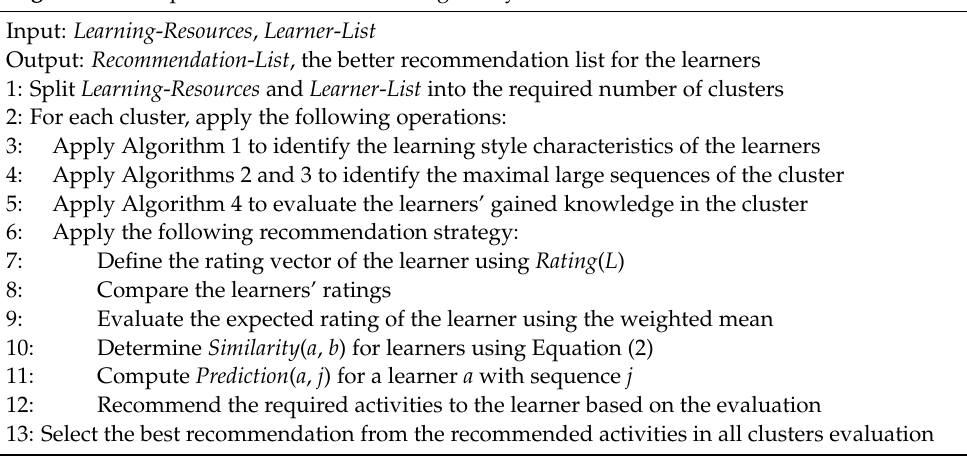
Algorithm 5 Proposed Cluster-Based Intelligent Hybrid Recommender